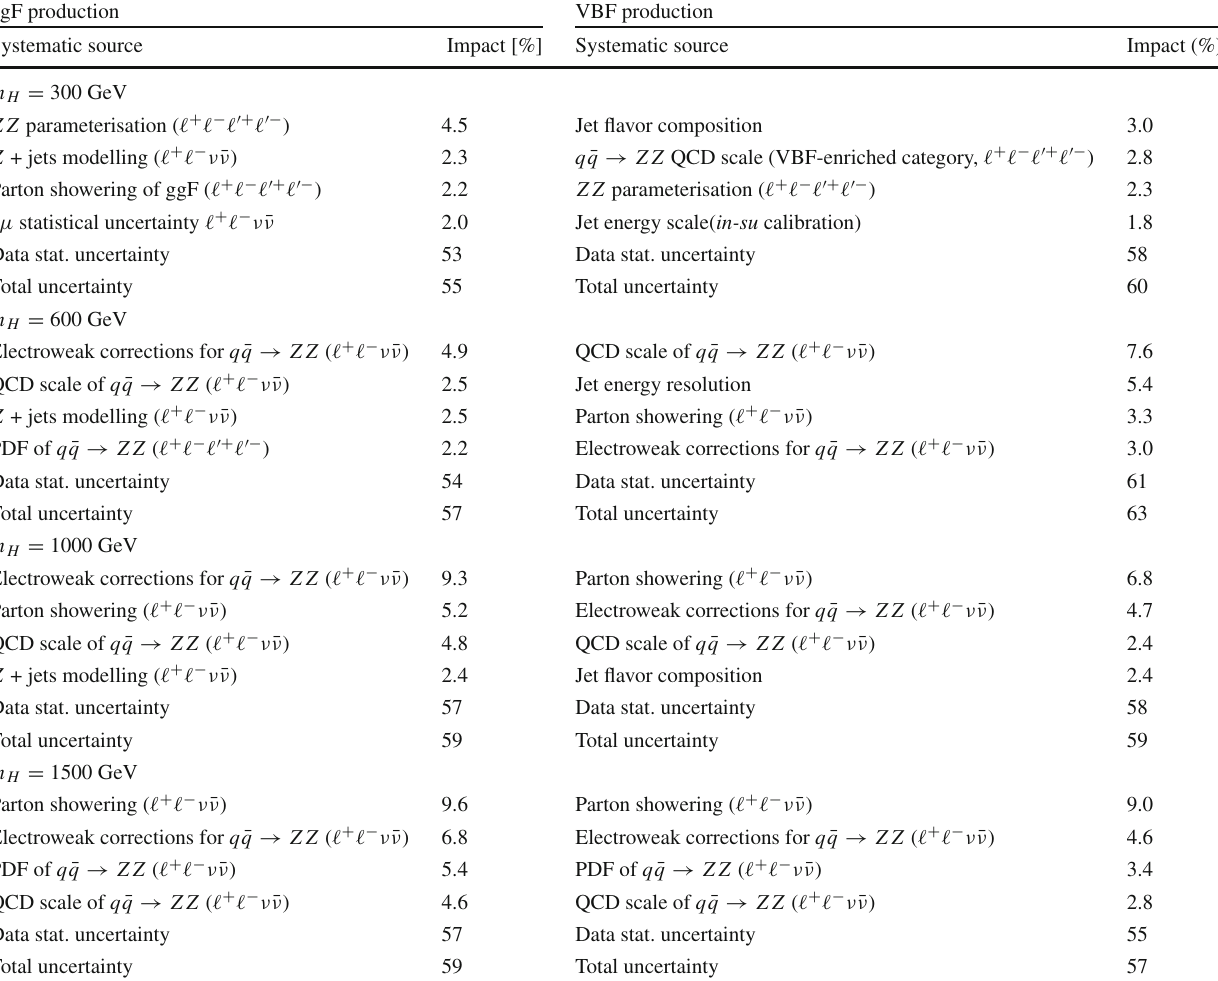
Table 1 Impact of the leading systematic uncertainties, the data sta- tistical uncertainties and the total uncertainties on the predicted signal event yield with the cross section times branching ratio being set to the